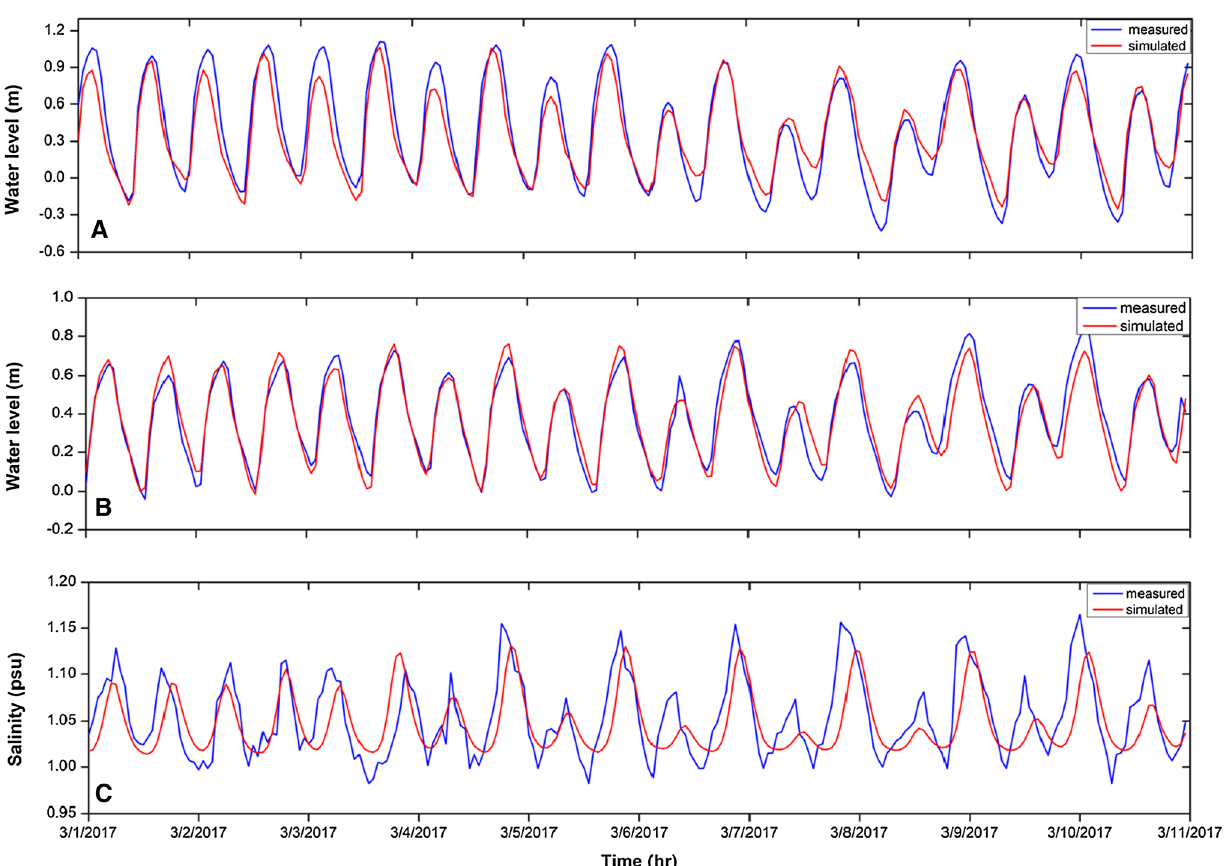
Fig. 2 Comparison between model results and measurements of water level and salinity at ( A & C : Sihan, B :Abo